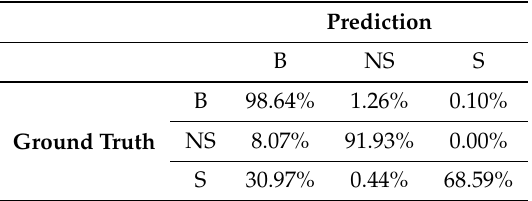
Table 8. Normalized pixel-level Confusion Matrix SegNet.